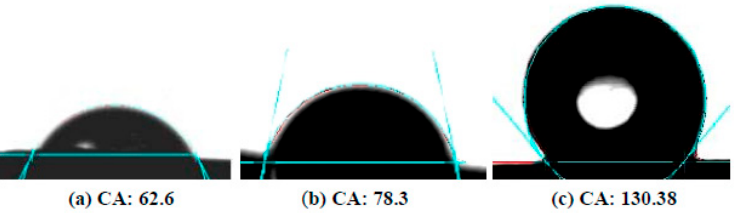
Figure 12. Contact angle images for droplets of water on Mg disks: ( a ) before immersion, ( b ) after 30 min, ( c ) after 1 h immersion time.